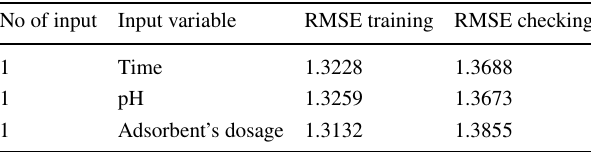
Table 3 One-input variable ANFIS (exhaustive search) for iron(II) removal